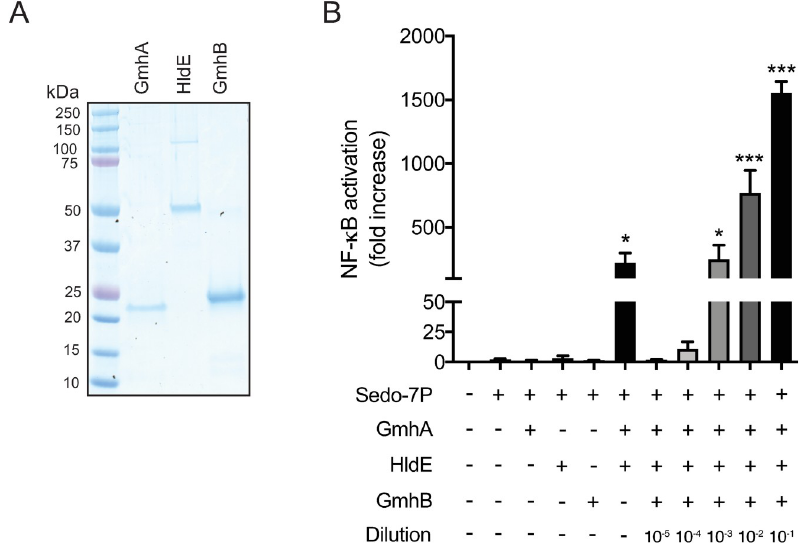
Fig 4. In vitro synthesized heptose metabolites prepared using C . jejuni enzymes activate NF- κ B. (A) SDS-PAGE gel stained with Coomassie Blue to visualize the purified His-tagged C . jejuni proteins GmhA, HldE and GmhB. (B) Inclusion of individual enzymes together with sedoheptulose-7-phosphate did not result in measurable NF- κ B activity, whereas the combination of GmhA and HldE, and GmhA, HldE and GmhB yielded in NF- κ B activating compounds. NF- κ B activation is measured as relative luciferase units and presented as fold increase in stimulated versus unstimulated cells. Values represent the mean ± SEM of three independent experiments performed in duplicate. � p < 0.05, �� p < 0.01, and ��� p <